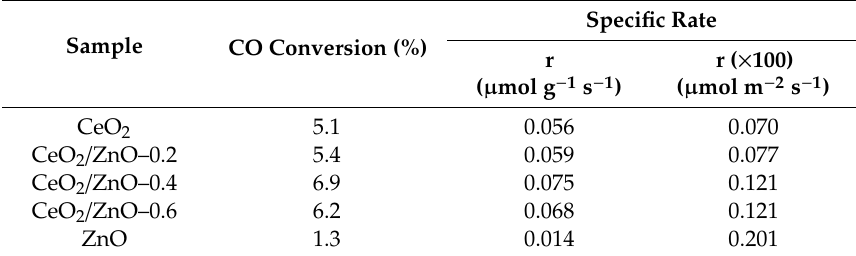
Table 4. Conversion of CO and specific rates of CeO 2 and CeO 2 / ZnO samples at 200 ◦ C. Reaction conditions: 0.2 vol.% CO and 1 vol.% O 2 in